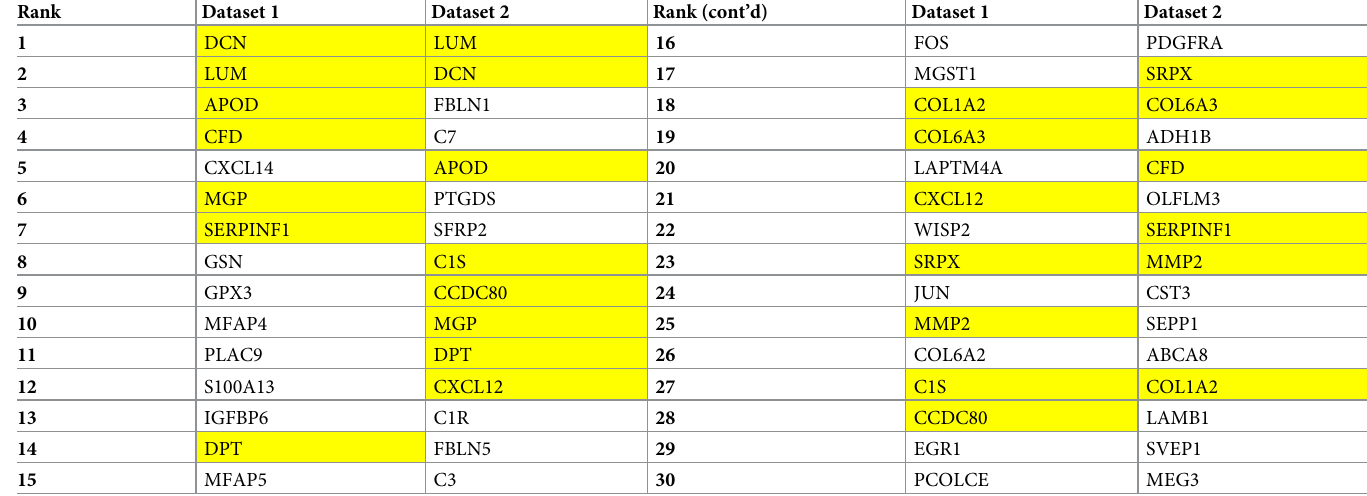
Table 3. Comparison of the attractors (top 30 genes) identified in the SVF of normal adipose tissue (Dataset 1) and in the normal pancreatic samples (Dataset 2). Common genes are highlighted in yellow. Rank